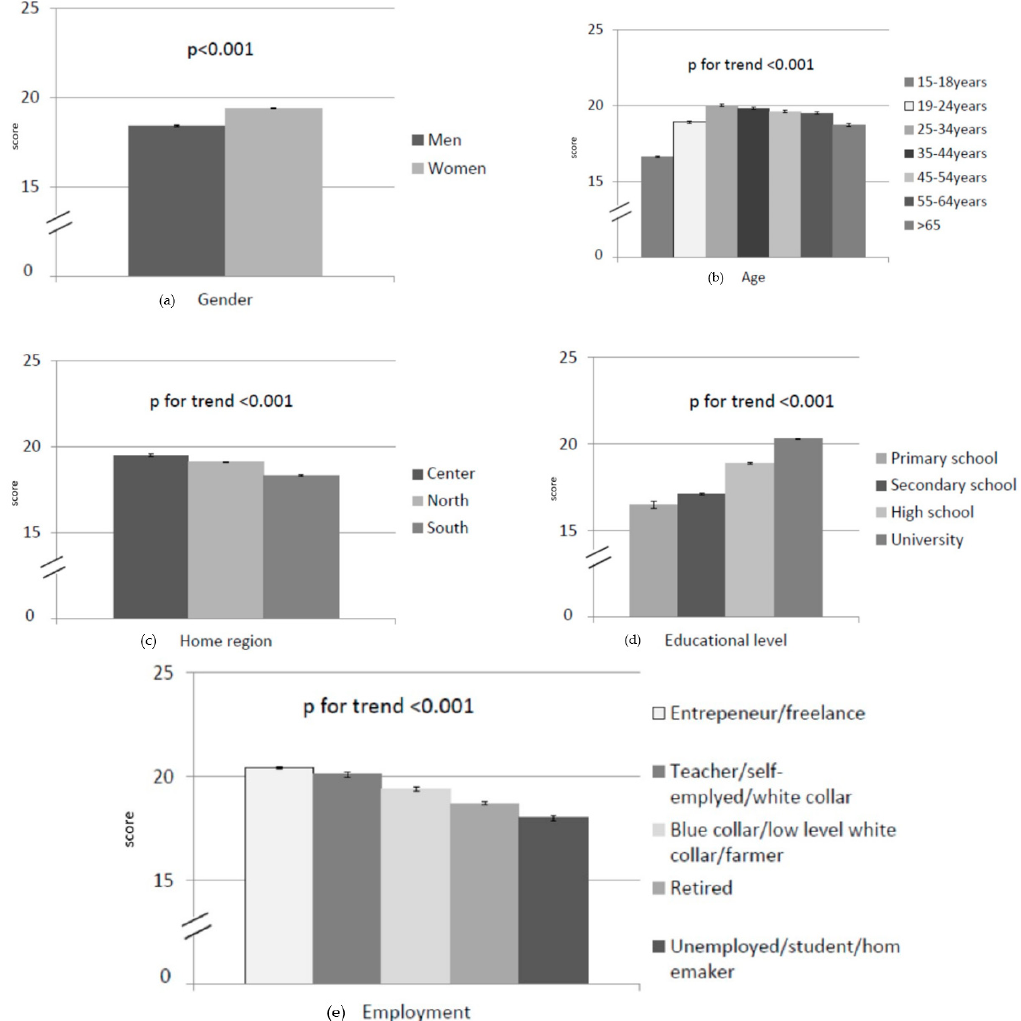
Figure 1. Knowledge about salt intake in relation to sociodemographic factors: ( a ) gender; ( b ) age; ( c ) home region; ( d ) educational level; and ( e ) employment. Results are expressed as mean ± standard error ( n = 11,618).